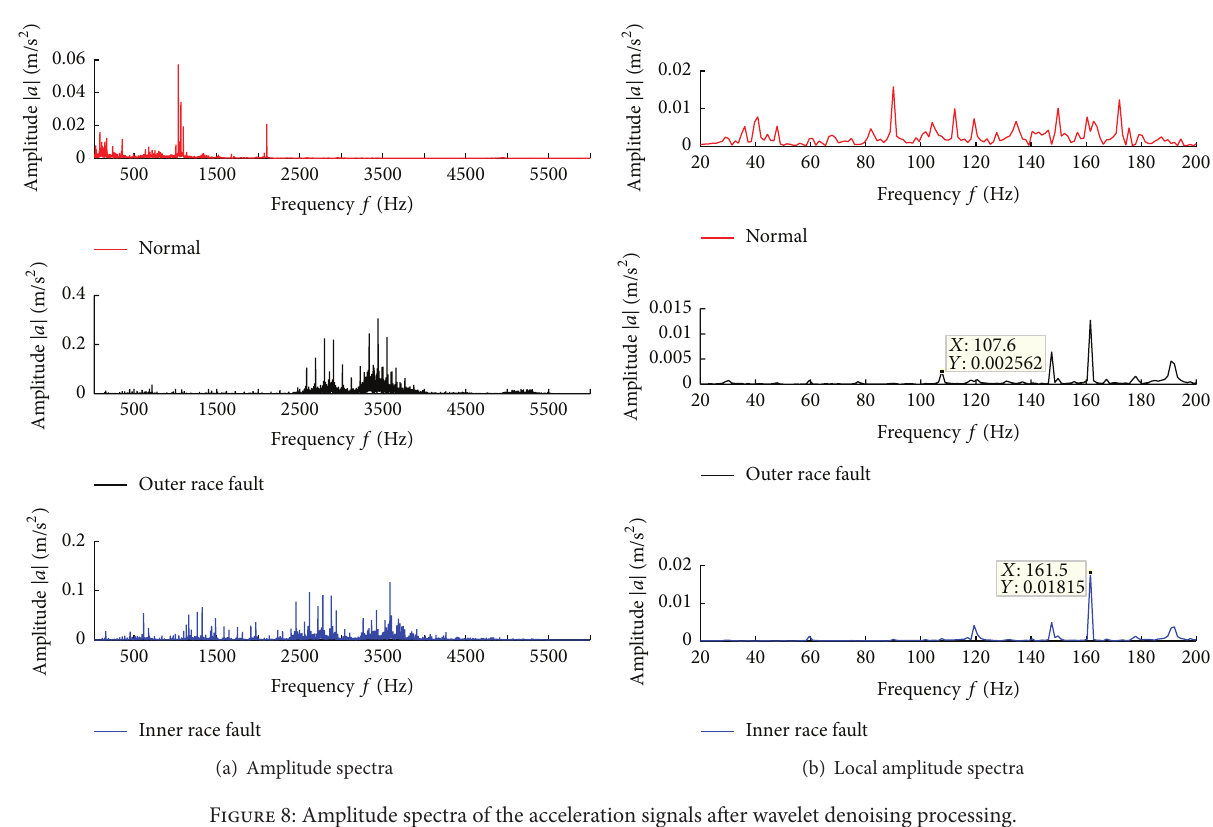
Figure 8: Amplitude spectra of the acceleration signals after wavelet denoising processing.